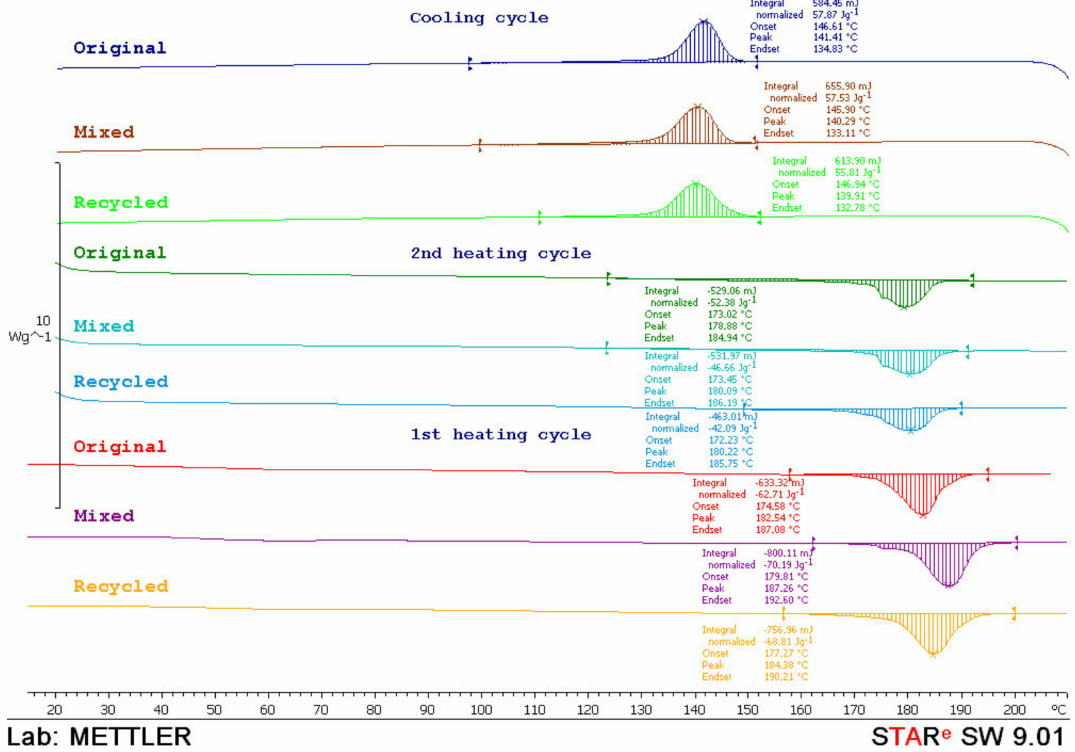
Figure 15. DSC thermograms of original, mixed and recycled polyamide obtained during the first and second heating cycle and the cooling